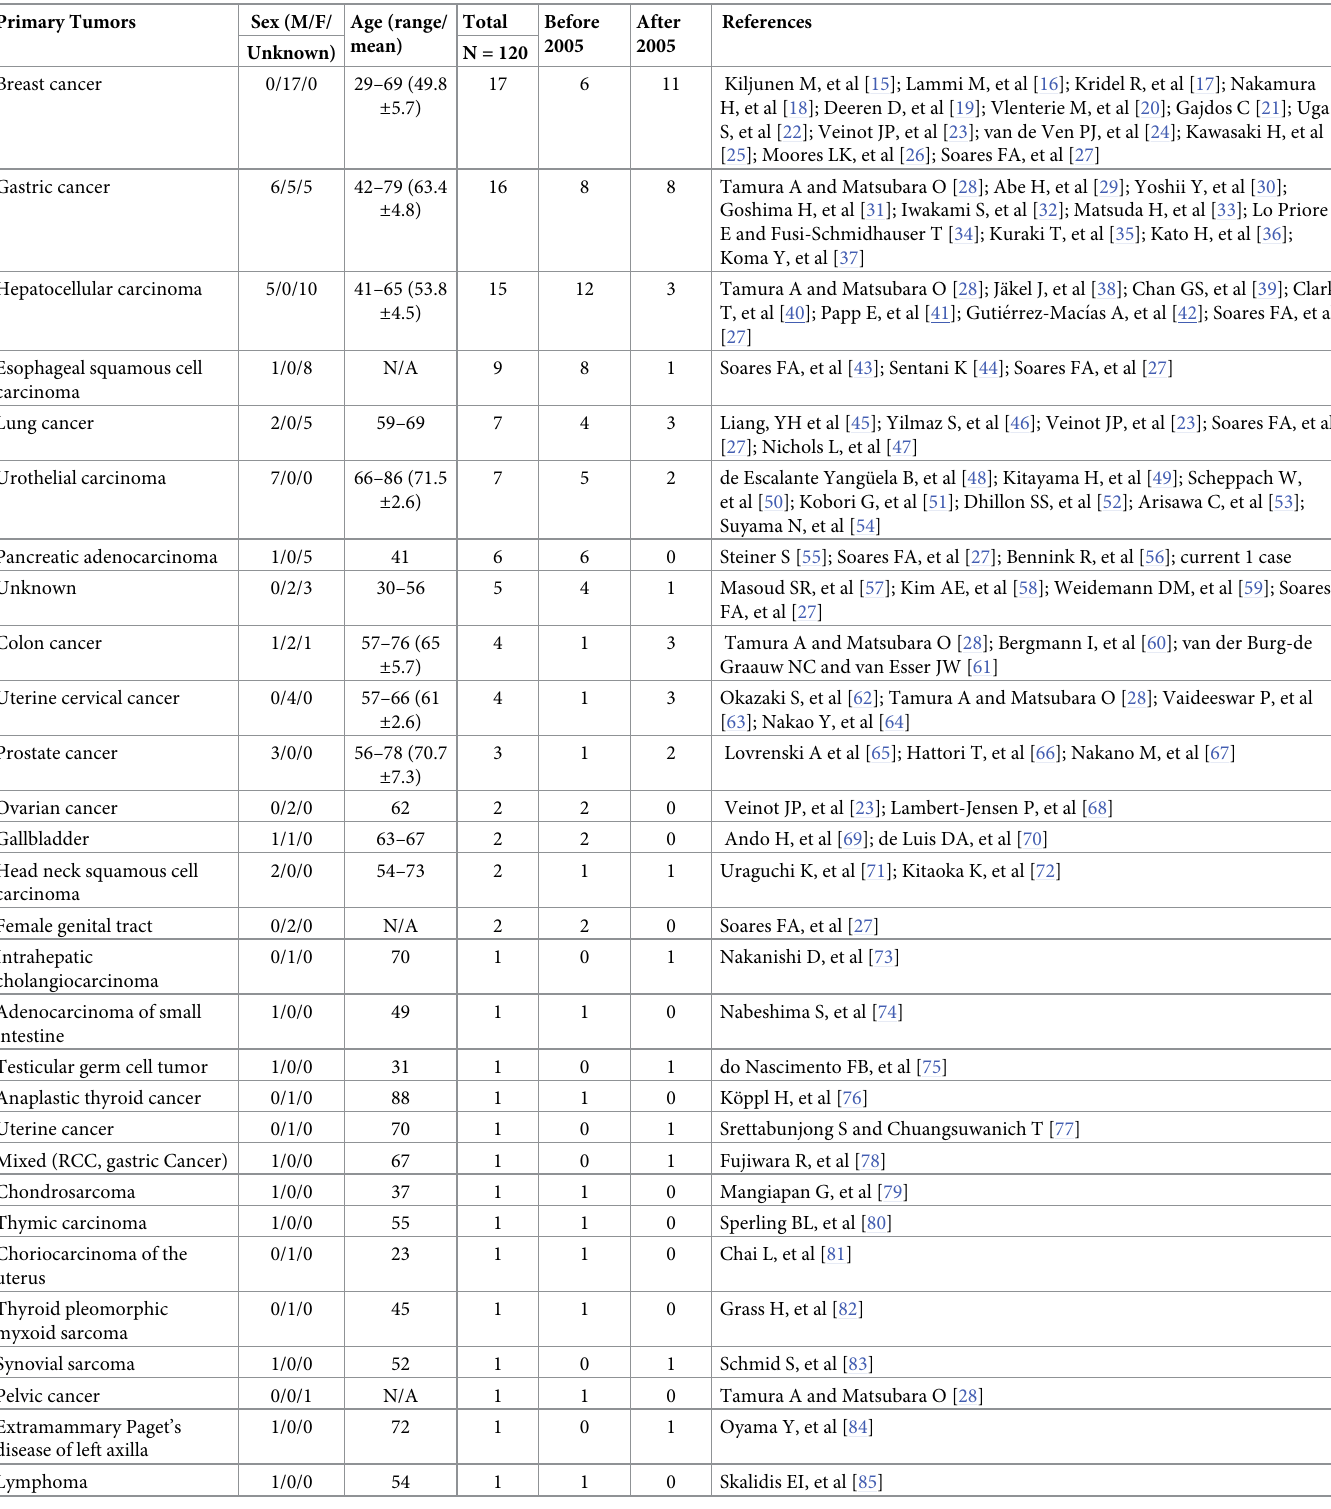
Table 4. Pulmonary tumor embolism cases between 1990 and 2020 in the literature. Primary